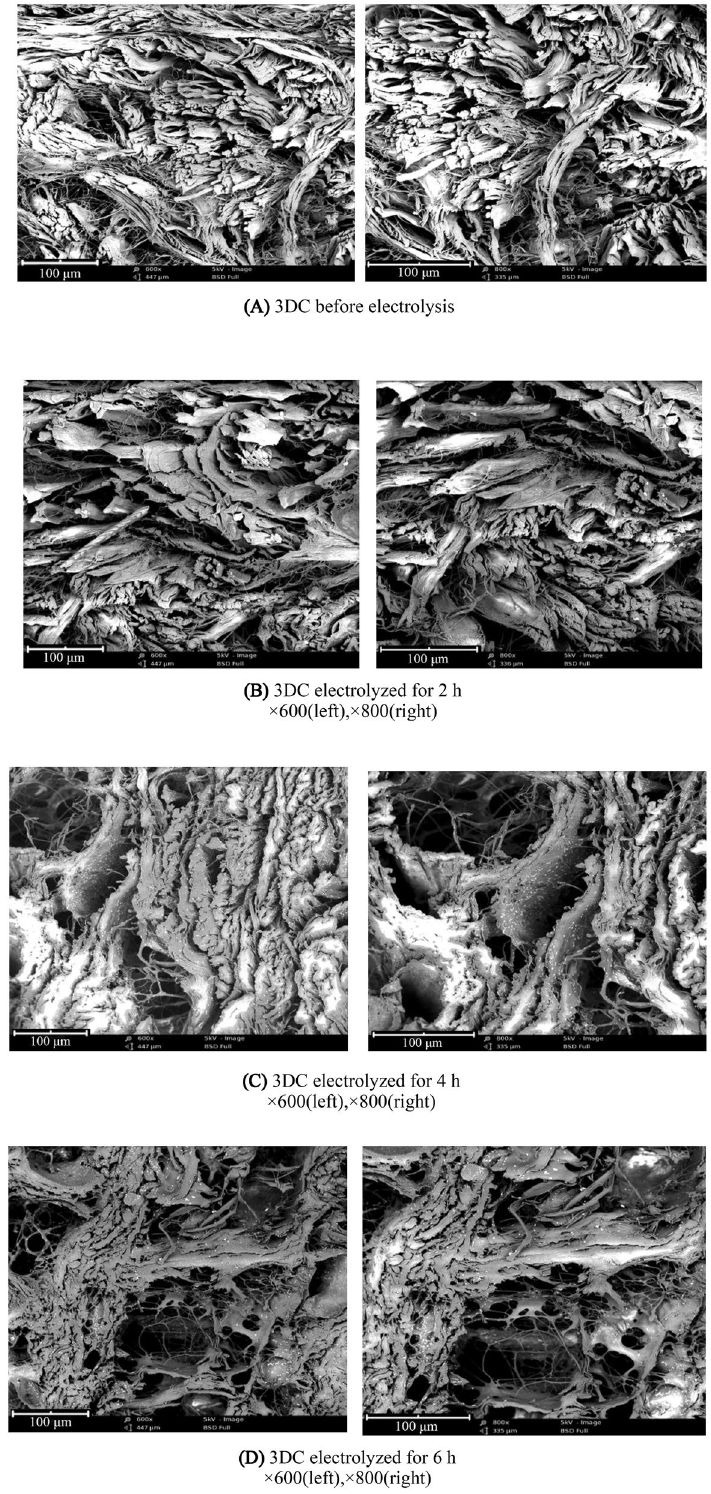
Figure 8. The SEM images of 3CD before electrolysis and electrolyzed for 2 h, 4 h, and 6